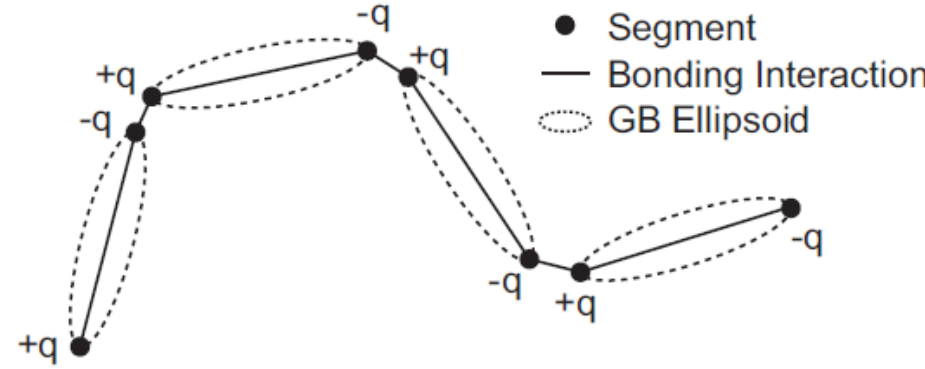
Figure 13. Schematic of the coarse-grained LCP model proposed by [107] (Reprinted with permission from [107]).